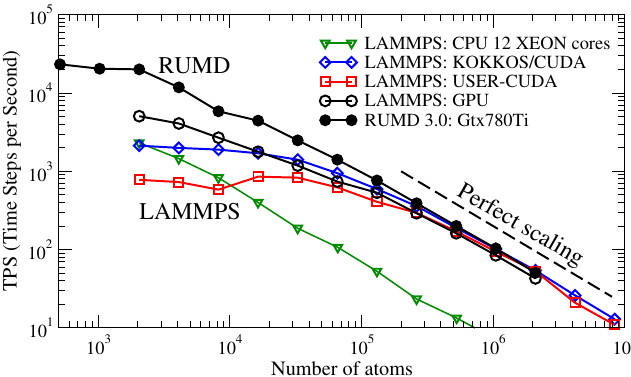
Figure 6: The Lennard-Jones LAMMPS benchmark: a melting FCC crystal is simulated at constant energy. LAMMPS results are downloaded from the LAMMPS webpage (see text). The vertical axis shows the number of simulated time steps per second of wall-clock time. At large system sizes all codes follows the ideal 1 / N scaling, and the GPU’s are 10-20 faster than LAMMPS running on 12 xeon cores. For RUMD good scaling is maintained down to quite small systems N ∼ 2000, and at small system sizes RUMD is thus considerably faster than the three GPU versions of